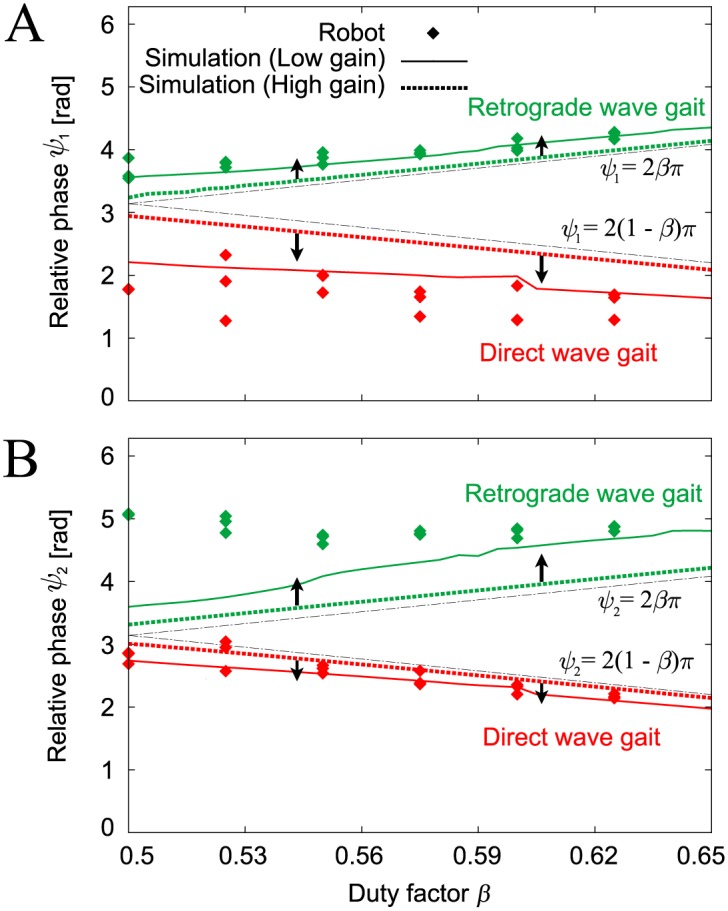
Relative phases (A) ψ1 and (B) ψ2 of the gaits obtained for duty factor β in the robot experiments and the computer simulations.Two stable gaits were obtained in the robot experiments: direct and retrograde wave gaits. The computer simulations used high and low feedback gains. When the feedback gain was reduced, the simulation results became much closer to the robot experimental results.